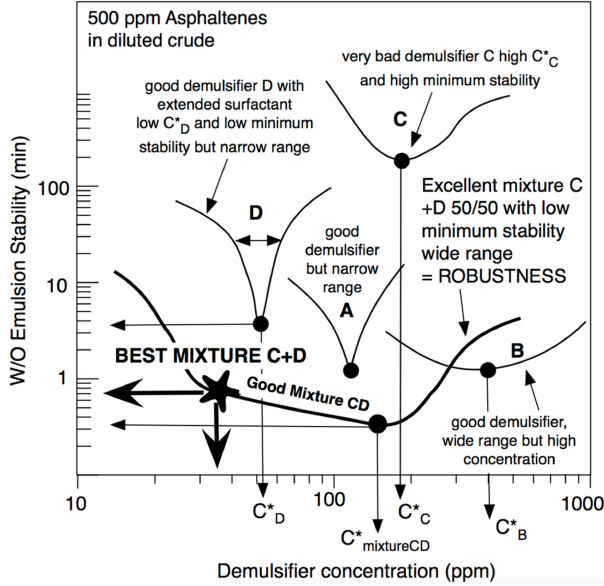
Figure 10. Performance (as minimum concentration to attain the minimum stability) and robustness (as the range of low stability zone) of the water in diluted crude emulsion when using different surfactant (A, B, C, D) and a proper C + D mixture, including extended